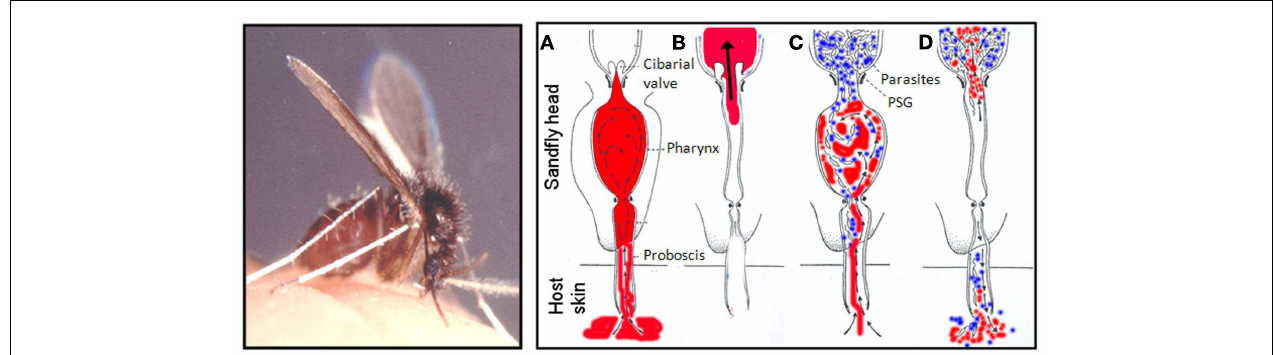
pharynx. Gel blockages have been observed in a large number of Leishmania -sand fly combinations described to date and characterized in both experimental ( L. mexicana in Lu. longipalpis ) and natural ( L. major in P. papatasi , L. infantum in Lu. longipalpis ) Leishmania -sand fly combinations. The PSG blockage forces open the cibarial valve allowing parasites and gel to reach the pharynx and foregut, allowing blood to mix with PSG when it is taken into the pharynx (C) . Since PSG is highly soluble, when blood is eventually drawn through the parasite-gel obstruction a proportion of midgut parasites and PSG are regurgitated by backflow into the skin of the vertebrate host (D) . Sand fly photo is courtesy of Prof. R.W. Ashford and the diagram is after Schlein et al.